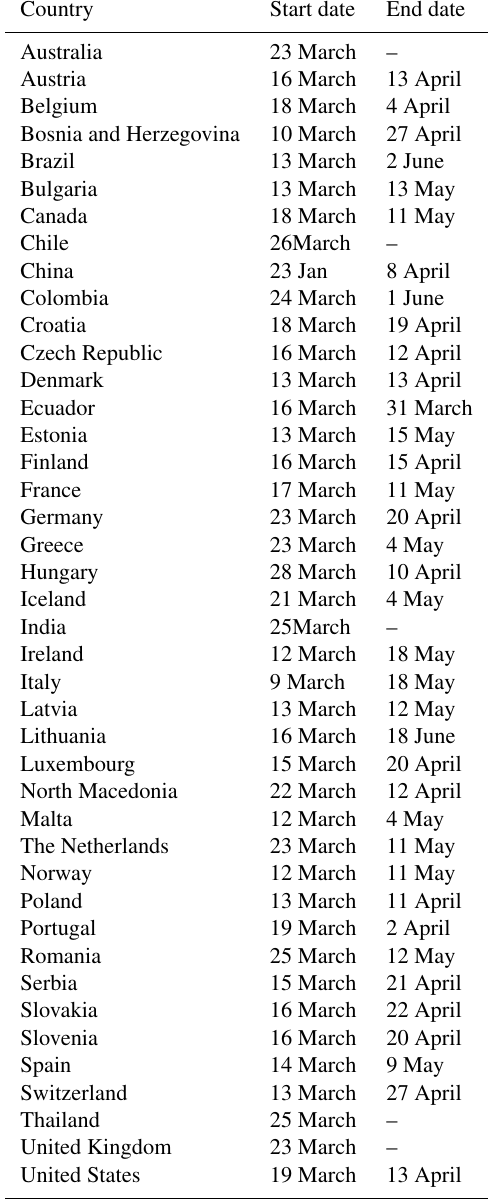
Table A2. National lockdown dates used for